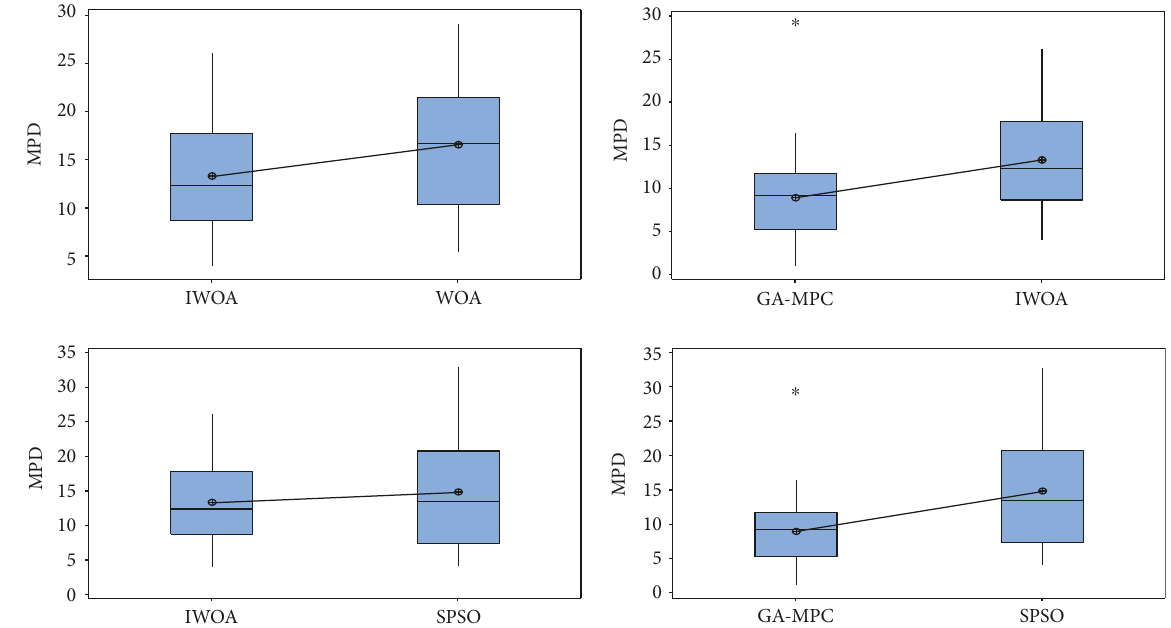
Figure 10: Boxplot diagrams for large-scale